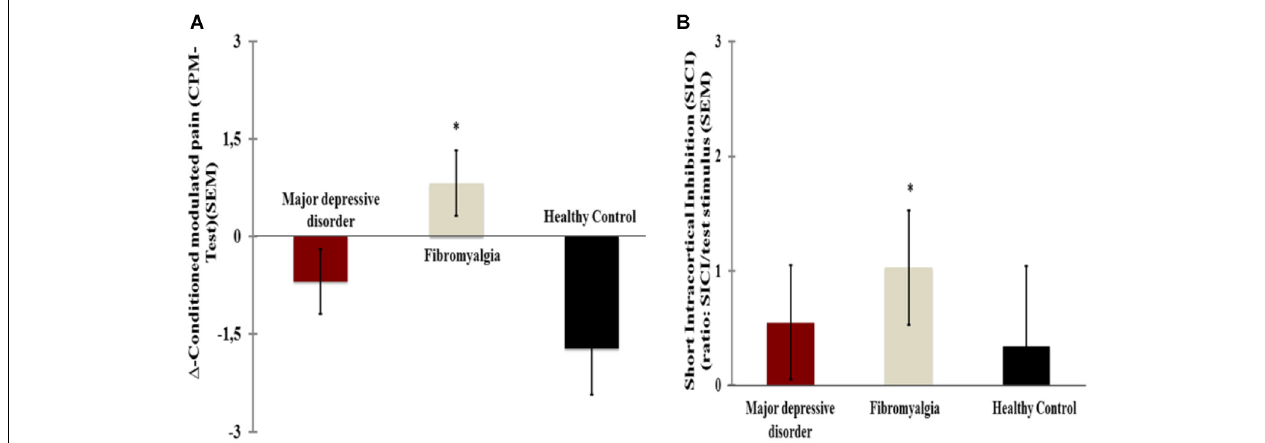
FIGURE 2 | Comparisons between [fibromyalgia ( n = 17) and major depressive disorder ( n = 18)]. (A) Short intracortical inhibition [(SICI) ratio: SICI/test stimulus]. (B) Change on Numerical Pain Scale (NPS) during CPM TEST. Error bars indicate standard error of the mean (S.E.M.). ∗ Positioned above the bars indicate differences between groups (fibromyalgia and major depressive disorder) assessed by MANCOVA with post hoc Bonferroni’s multiple comparison test.